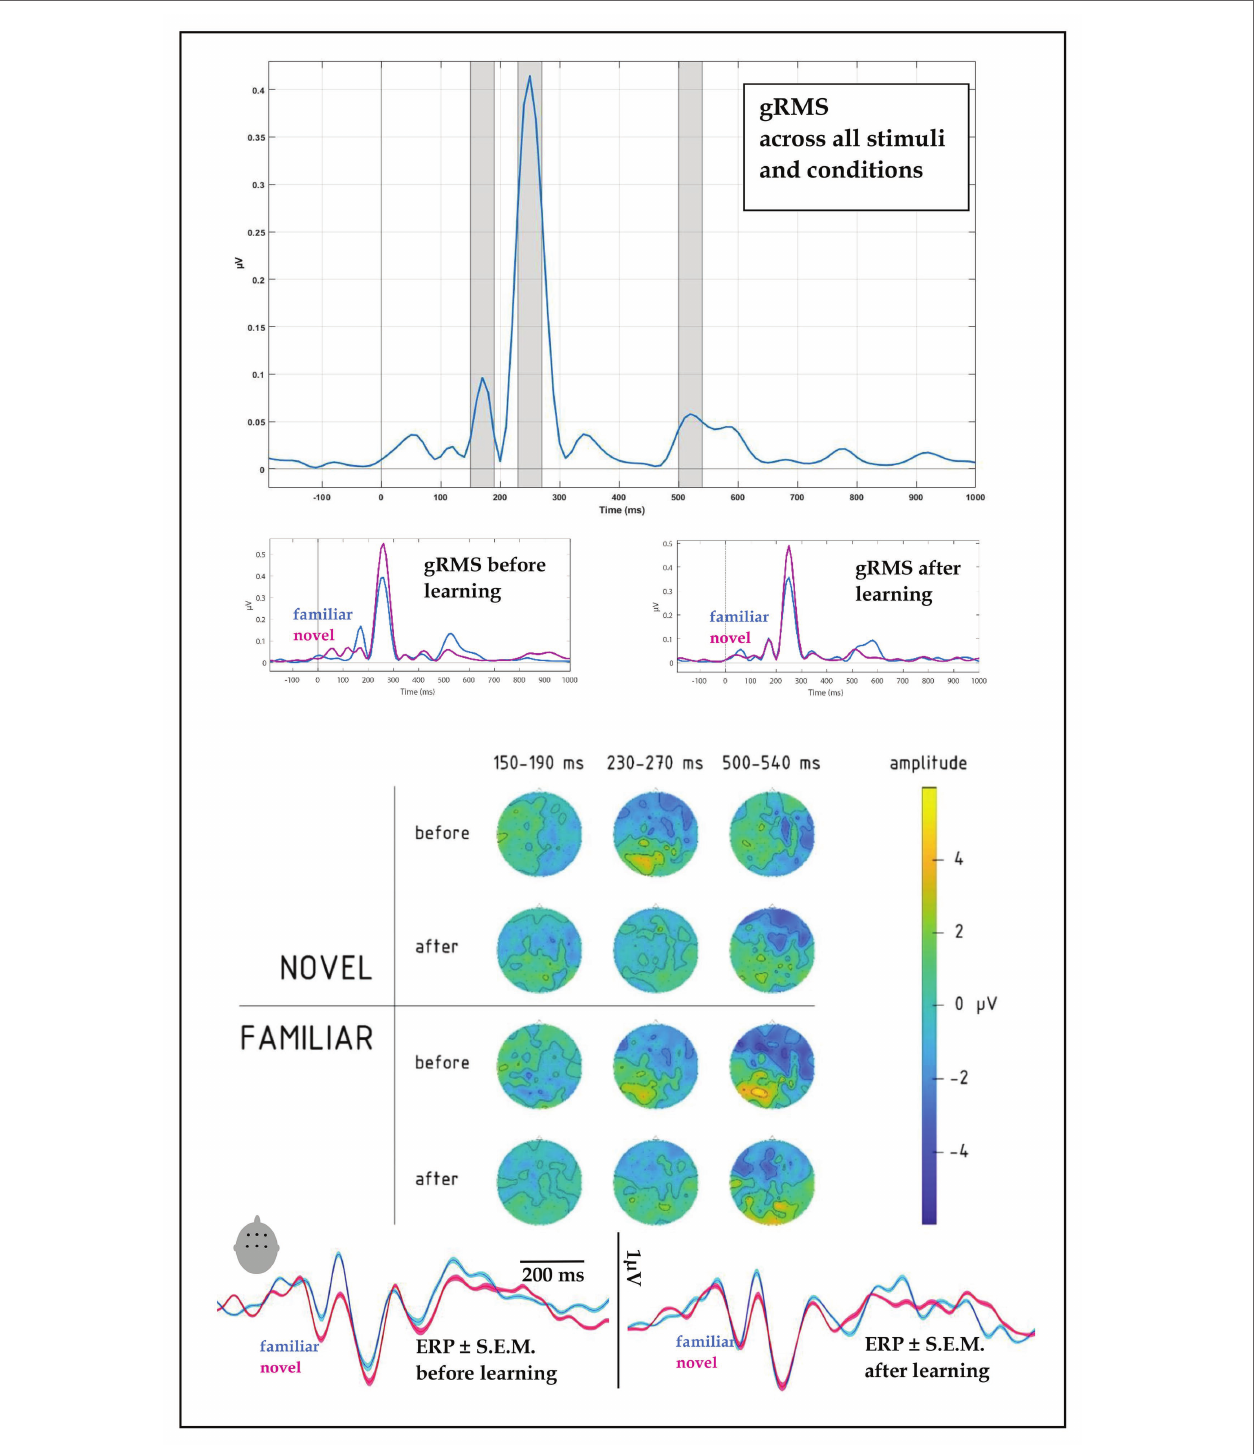
FIGURE 3 | (top) Global root mean square (gRMS) response, computed over all conditions, subjects and electrodes, indicated the most prominent peaks at 170, 250, and 520 ms (with intervals +/ − 20 ms highlighted, top panel ). (upper middle) gRMS for novel and familiar words before and after learning indicated changes in relative dynamics, particularly at the first and last peaks. (lower middle) Topographies of average electrophysiological responses in the 150–190, 230–270, and 500–540 ms intervals for novel vs. familiar words before and after learning session, collapsed across learning types, indicated amplitude and distribution changes after the learning block. (bottom) ERPs for familiar and novel words before and after learning, computed over fronto-central leads (F1, Fz, F2, C1, Cz, and C2): amplitude and SE of